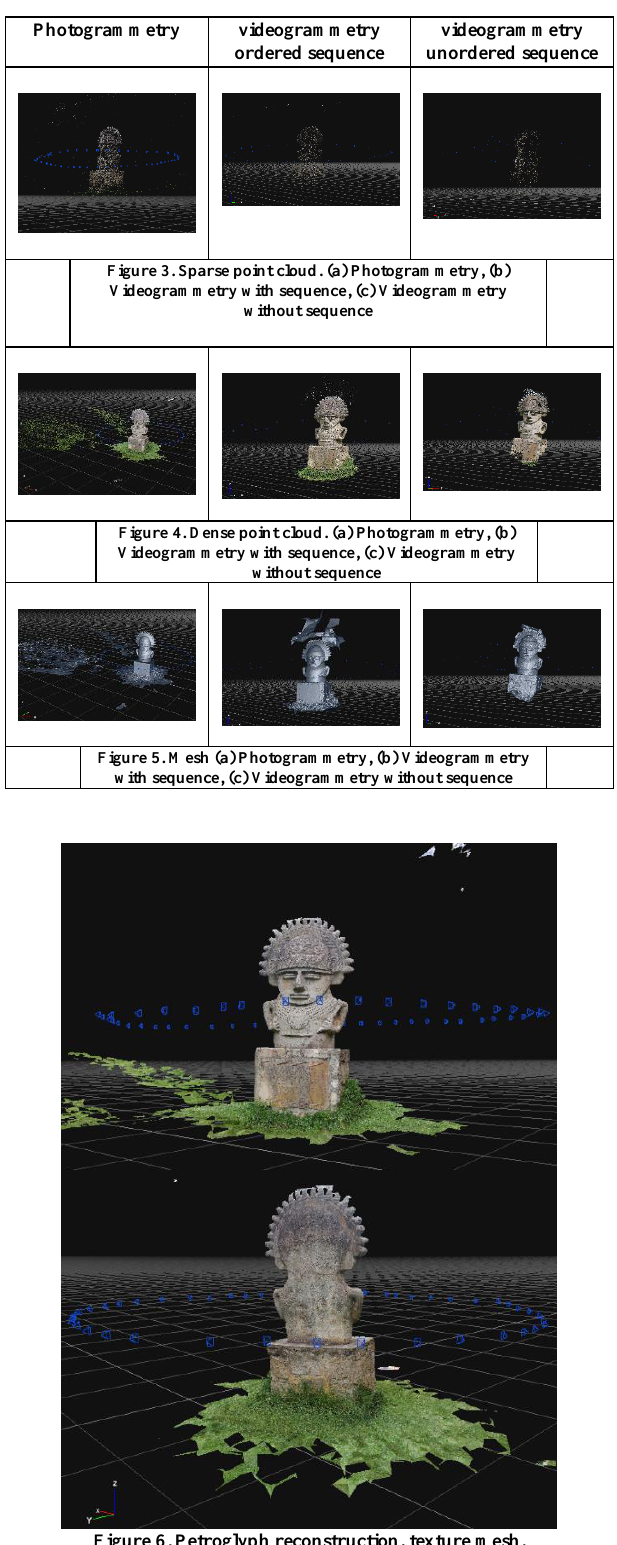
Figure 6. Petroglyph reconstruction, texture mesh. Photogrammetric method.